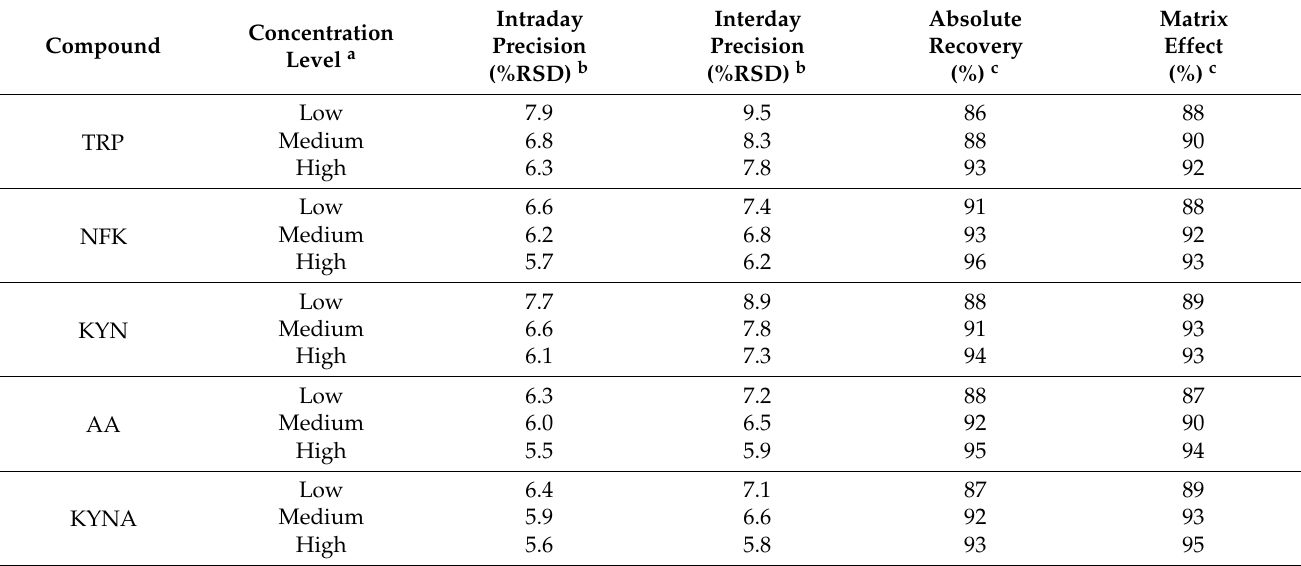
Table 2. Absolute recovery, precision and matrix effect data obtained on fortified whole blood VAMS